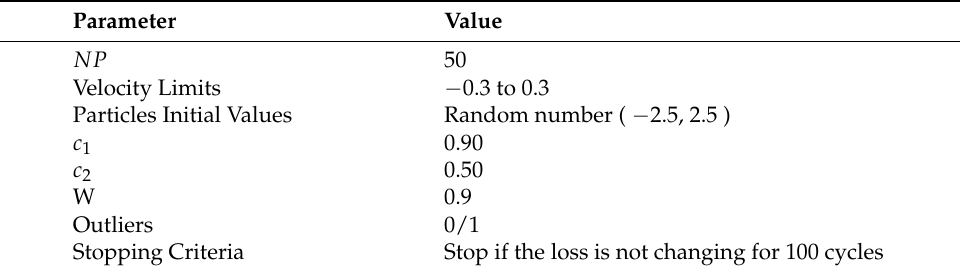
Table 7. PSO settings for the distortion correction task.